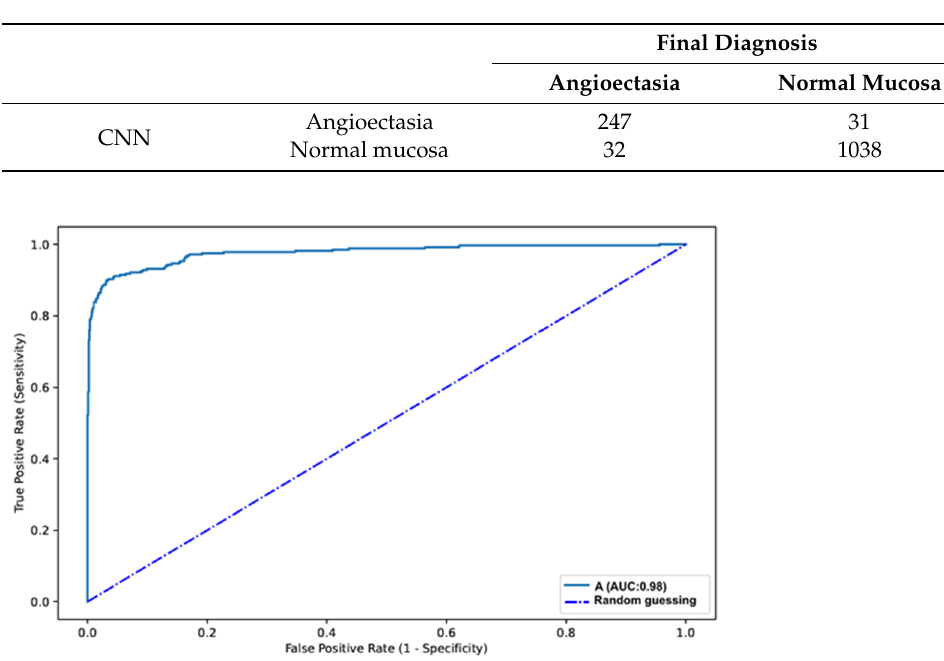
Figure 4. ROC analysis of the network’s performance in the detection of gastrointestinal angioectasia vs. normal mucosa. ROC—receiver operating characteristic. A—Angioectasia.